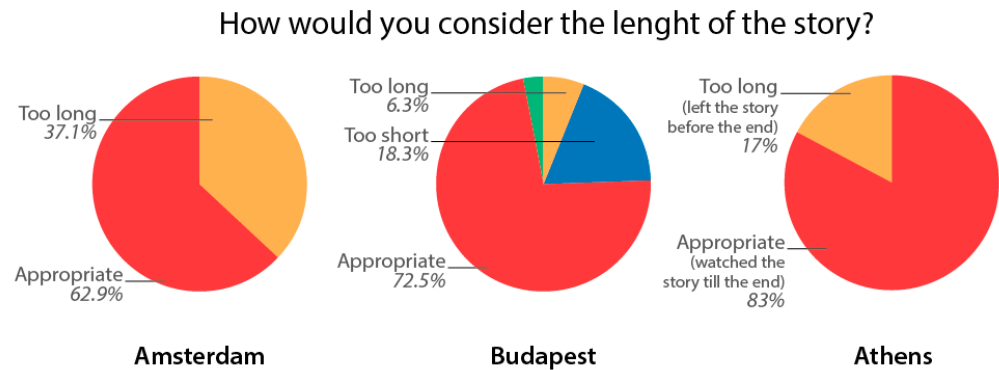
Figure 21. Image representing the results of one of the questions done to museum visitors about the length of the story, at APM, NHM, and BCM.